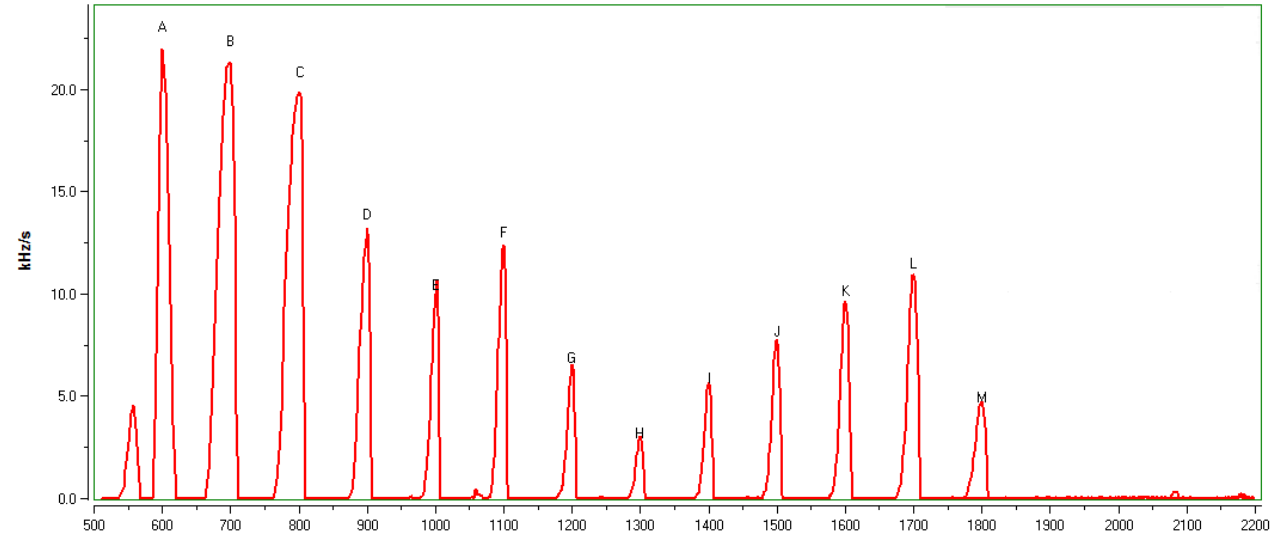
Figure 1. Calibration test chromatogram of 13 n-alkanes standard solution. Table 1. Calibration table of 13 n-alkanes standard solution.